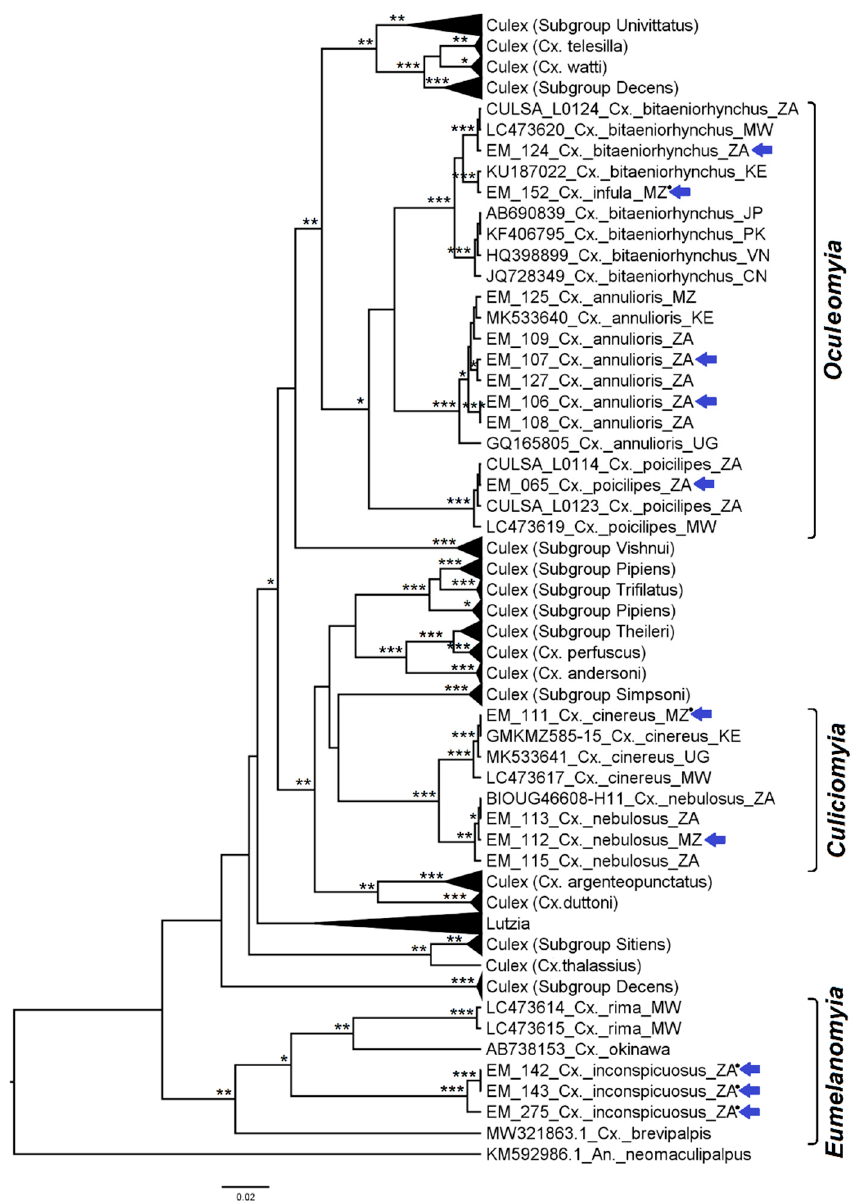
Figure 12. Phylogenetic analysis of 170 partial coxI nucleotide sequences from Culex and Lutzia mosquitoes, presenting the subgenera Oculeomyia , Culiciomyia , and Eumelanomyia . At specific branches, the number of * indicates the tree topological support revealed by the different phylogenetic reconstruction methods, assuming relevant bootstrap and aLRT values above 75% and posterior probability values above 0.80. The sequences obtained in this work are indicated by the “EM” code and those with associated genitalia are indicated by horizontal blue arrows. The sequences downloaded from GenBank and Boldsystems are indicated by their respective accession numbers and access codes (respectively); the symbol “.” after the code of our sequence indicates that said sequence was not identified by Boldsystems. Their country of origin [South Africa (ZA), China (CN), Japan (JP), Malawi (MW), Mozambique (MZ), Pakistan (PK), Kenya (KE), Vietnam (VN), Uganda (UG)] are also indicated. The vertical lines mark the subgenera of Culex ; the collapsed branches are the species of the genus Lutzia and informal groups of the genus Culex .